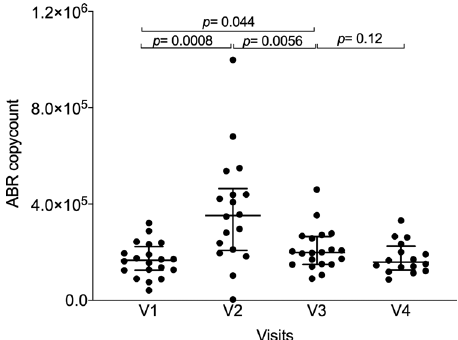
Fig. 4 Number of reads mapped against antibiotic resistance genes identi fi ed through metagenomic sequencing from V1 to V4 for the per- protocol population ( n = 20). P -values were determined by two-sided signed-rank Wilcoxon paired test, no adjustments were made for multiple comparisons, error bars indicate median and interquartile range. ABR is for antibiotic resistance genes. Source data are provided as a Source Data fi